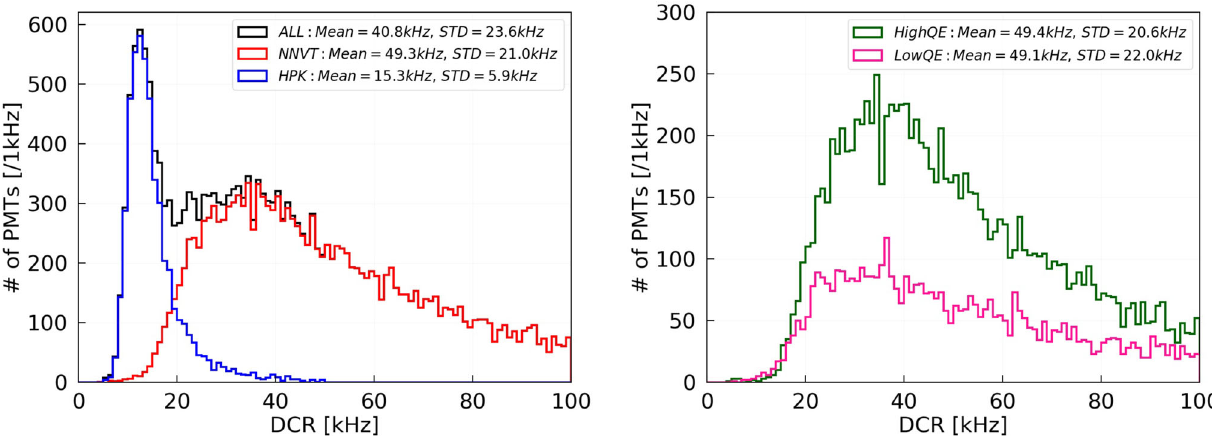
Fig. 24 Measured DCR distribution of qualified PMTs. Left: black solid: all PMTs; red solid: NNVT; blue solid: HPK; Right: dark green solid: High_QE; deep pink solid: Low_QE. Note: the DCR of NNVT PMTs is selected with ≤ 100 kHz